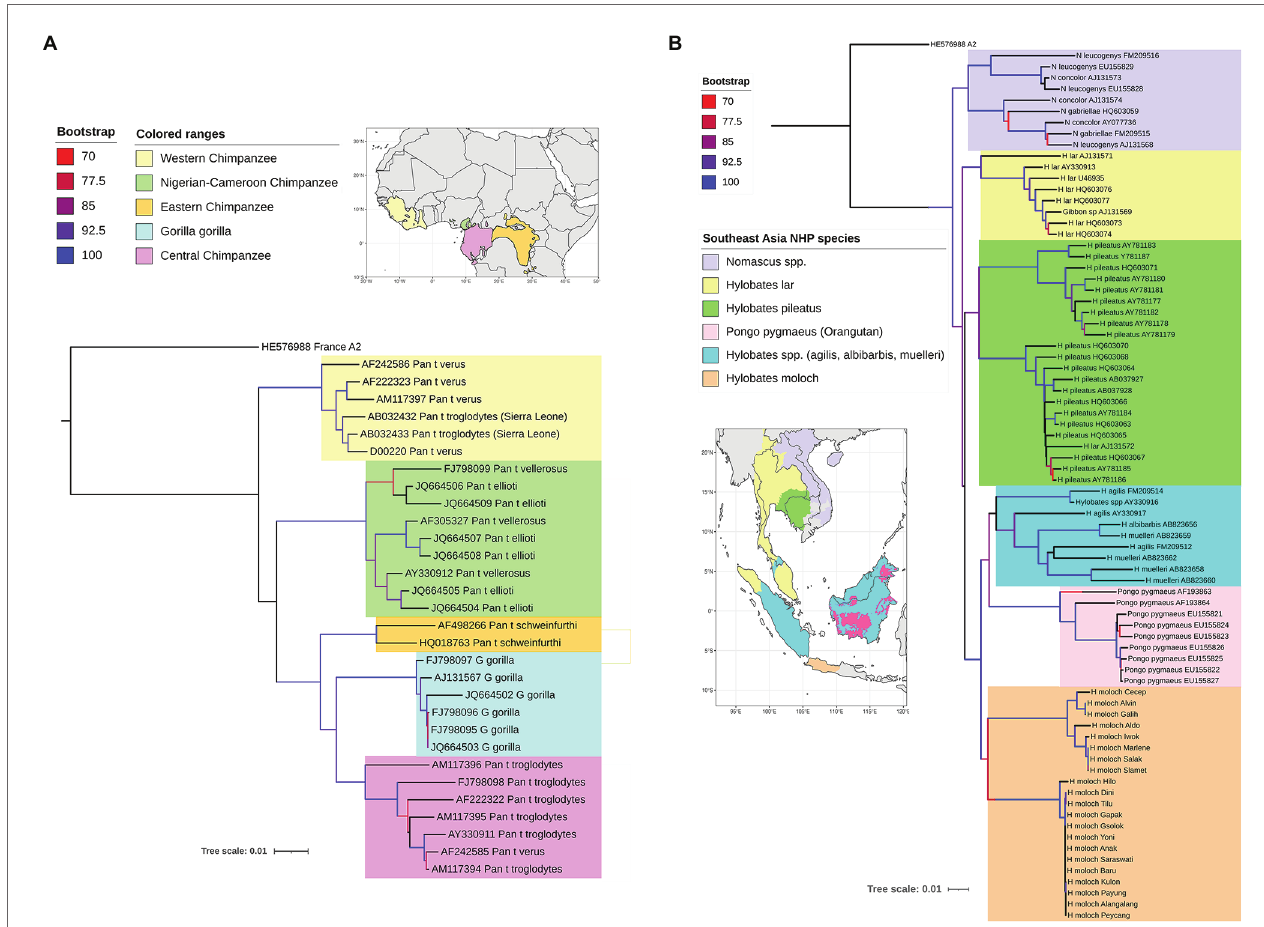
FIGURE 3 | Maximum likelihood (ML) phylogenetic tree of full-length HBV genome sequences extracted from non-human primates (A) in Africa and (B) Southeast Asia, and reference HBV subgenotype sequences obtained from GenBank. The natural habitat locations of the non-human primates are shown in the corresponding maps, with same the color code used on the ML trees for the different host species. The trees were inferred using IQ-TREE v1.6.5 (Nguyen et al., 2015). The best-fit models determined by ModelFinder (Kalyaanamoorthy et al., 2017) were GTR+F+R2 and GTR+F+R4, respectively. Clade support was assessed using 1,000 pseudo replicates generated with the UFBoot non-parametric bootstrap procedure (Hoang et al., 2018), and bootstrap values >70% are shown by a color scale on the tree branches. The ML tree was annotated using iTOL v5.7 (Letunic and Bork, 2019). Branch lengths are scaled to the number of nucleotide substitutions per sequence